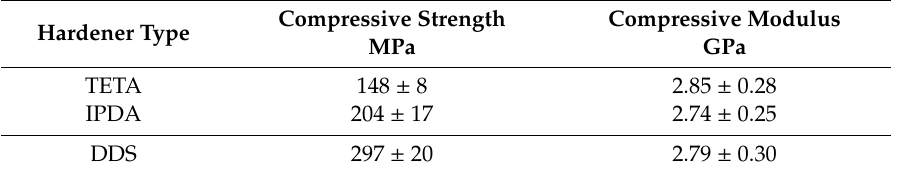
Table 5. Results from compressive tests at room temperature of resin with di ff erent